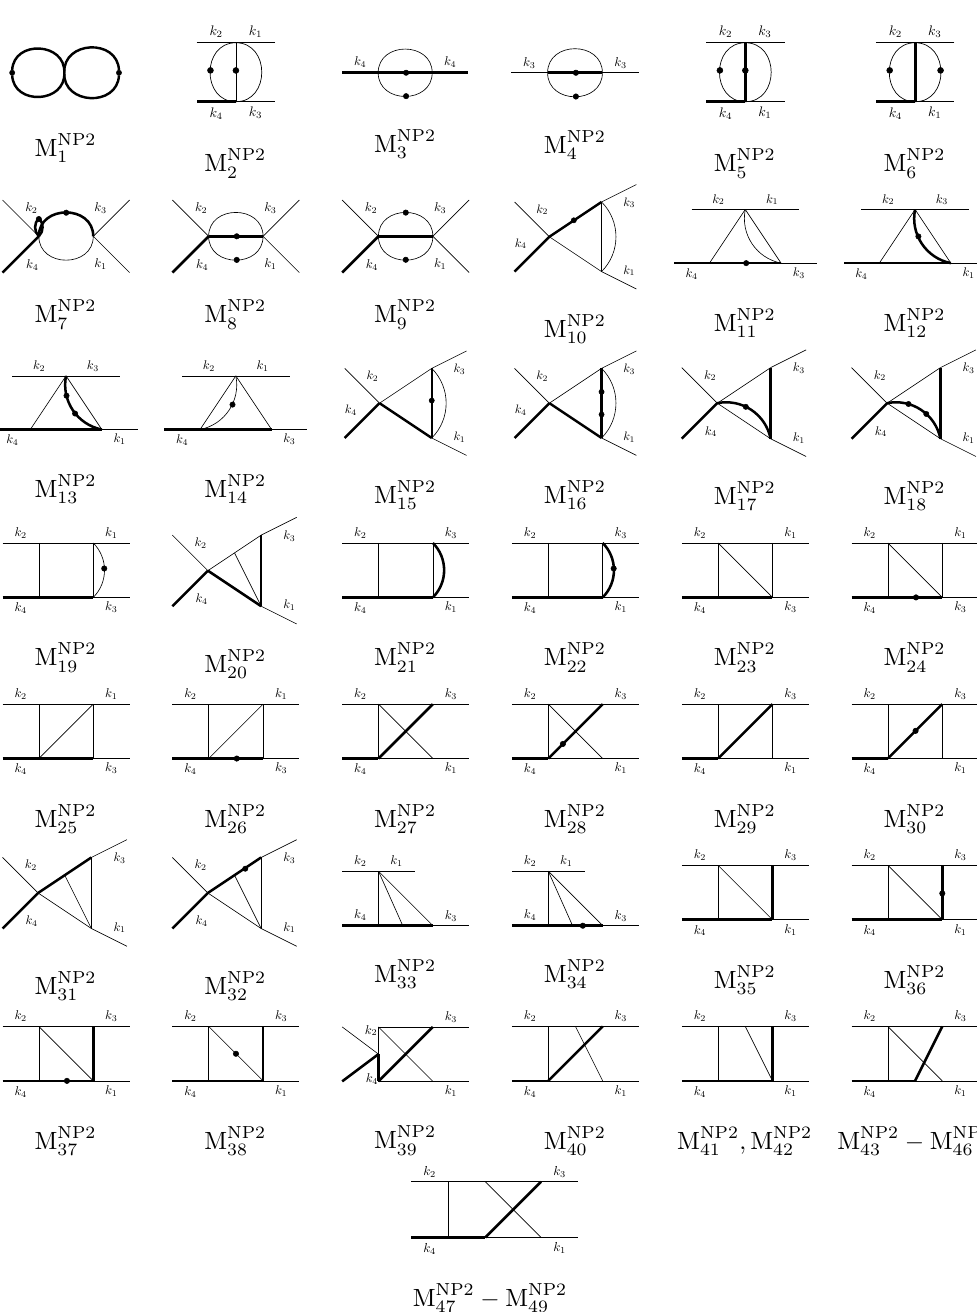
Figure 6. Master integrals in the NP2 topology. The thick lines stand for massive top quarks while the others represent massless particles. One black dot indicates one additional power of the corresponding propagator. The numerators can be found in the